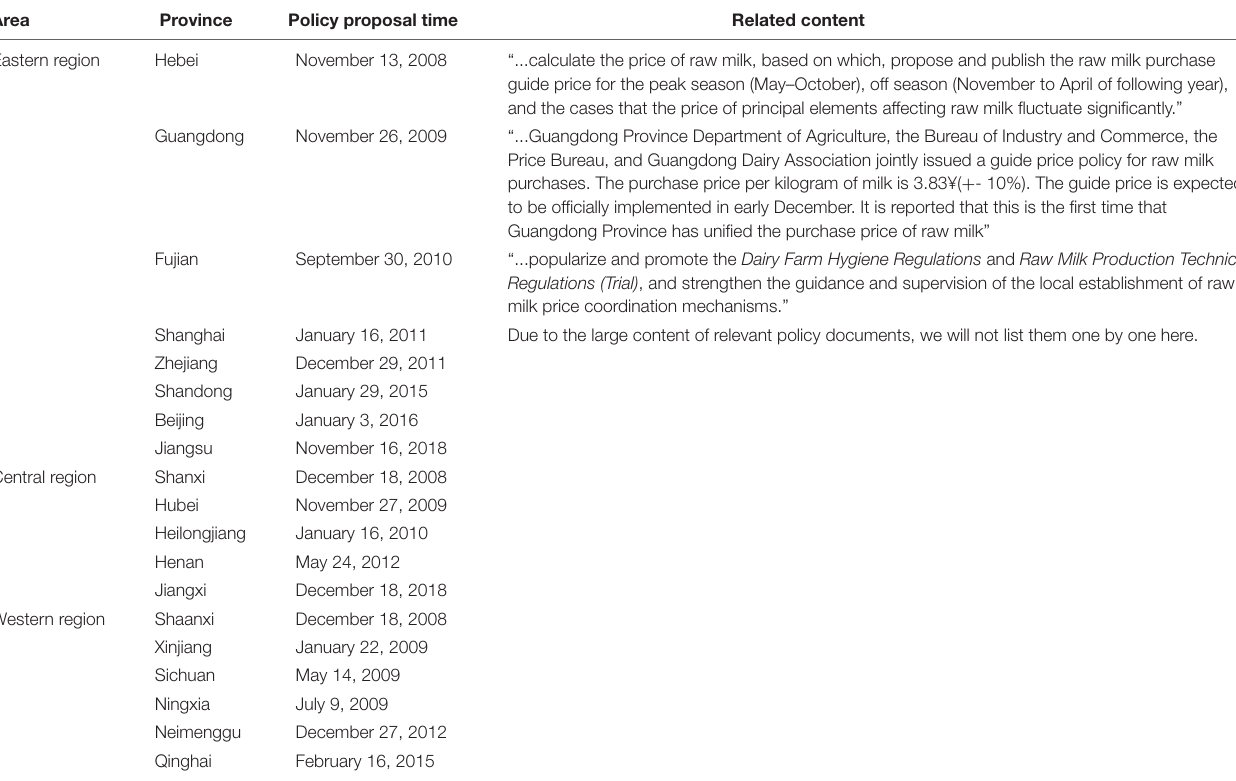
TABLE 1 | Price support policy formulation and policy launch time by